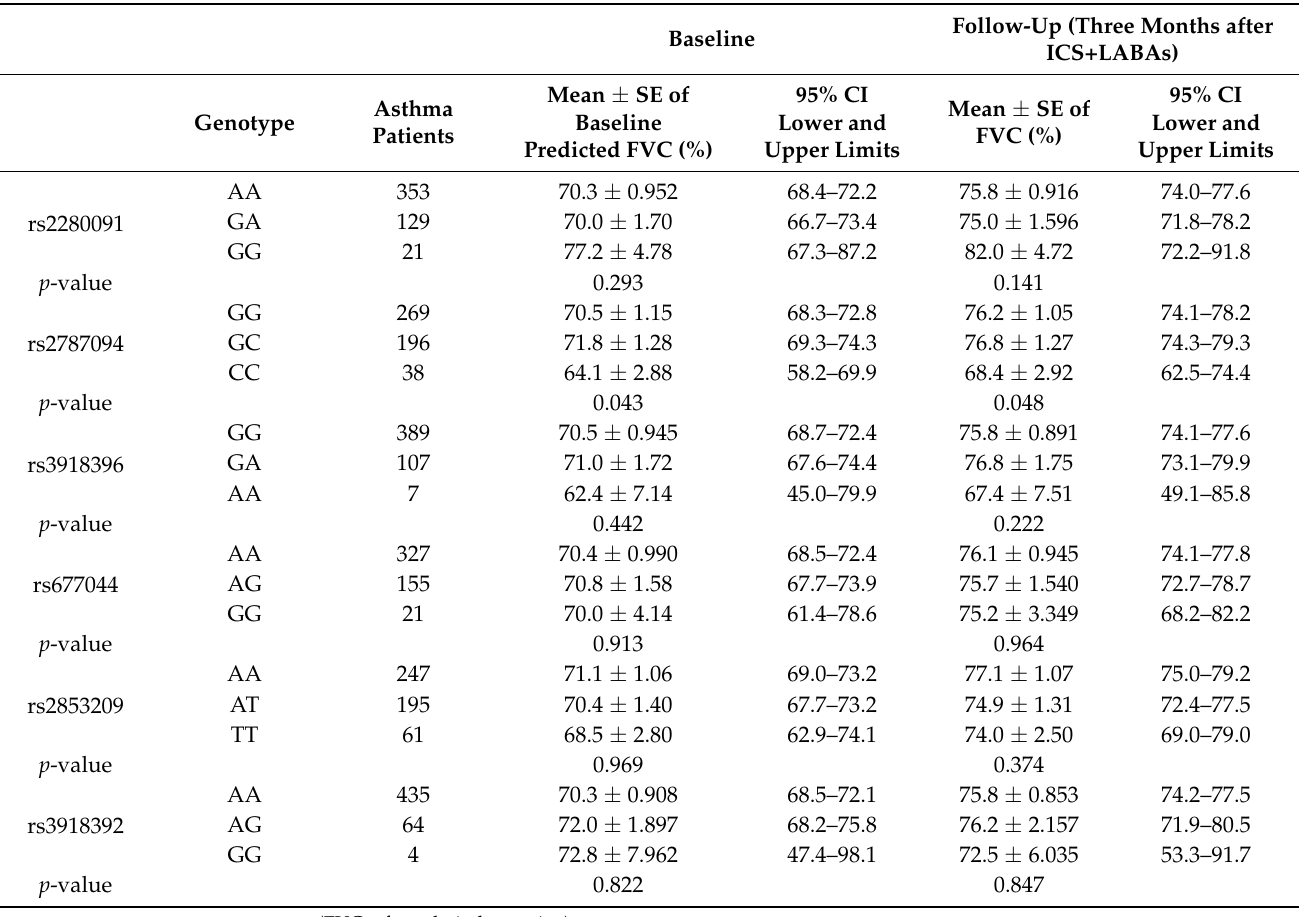
Table 3. Predicted baseline FVC (%) and FVC (%) improvements after three months of inhaled corticos- teroids (ICS) and long-acting beta-agonists (LABAs) with various SNPs of ADAM33 in asthma patients.